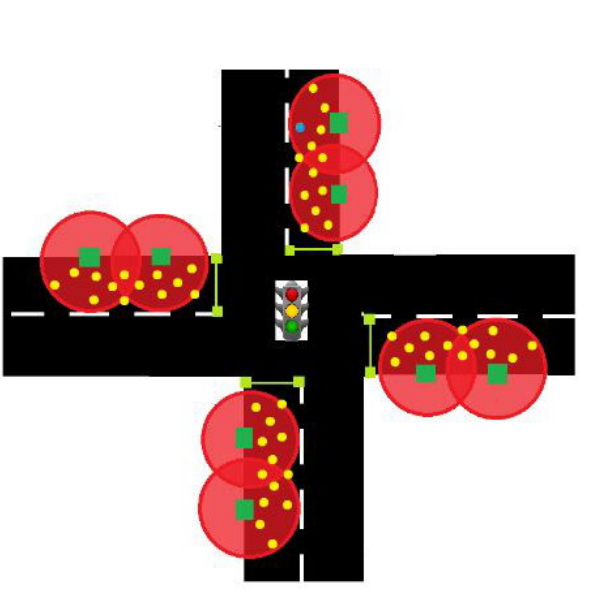
Figure 1. Representation of the System